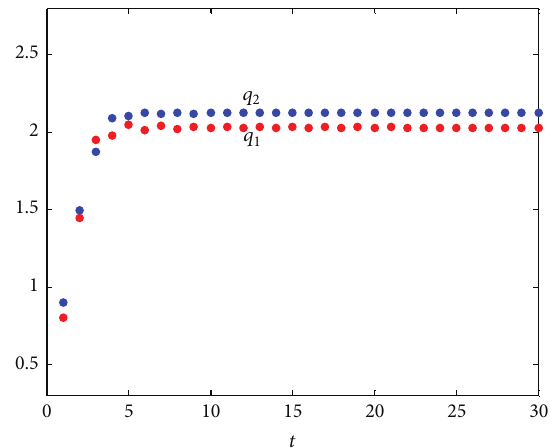
Figure 11: The stable status of the system as a function of the parameter 𝛼 with the controlling factor 𝑘 = 2.5